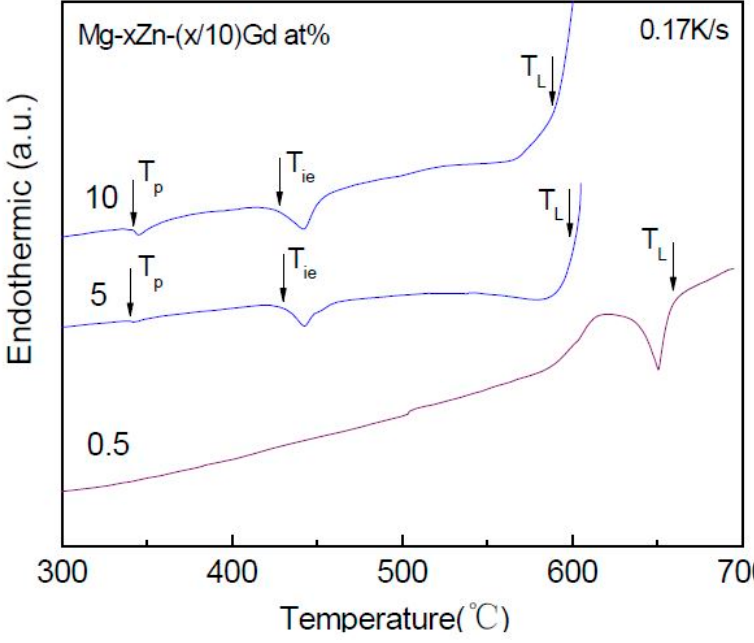
Figure 13. DTA heat trace of Mg-Zn-Gd alloys with Zn/Gd ratio of 10 (Sample 1, 7, 48). Table 5. Characteristic temperatures for Mg-Zn-Gd alloys in the differential thermal analysis (DTA) curves. Characteristic Temperatures (°C ± 0.2) Alloys (Zn/Gd Ratio)